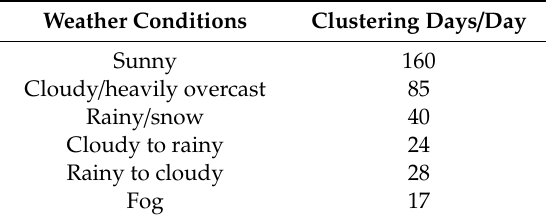
Figure 4. Sample points distribution. Table 3. Clustering